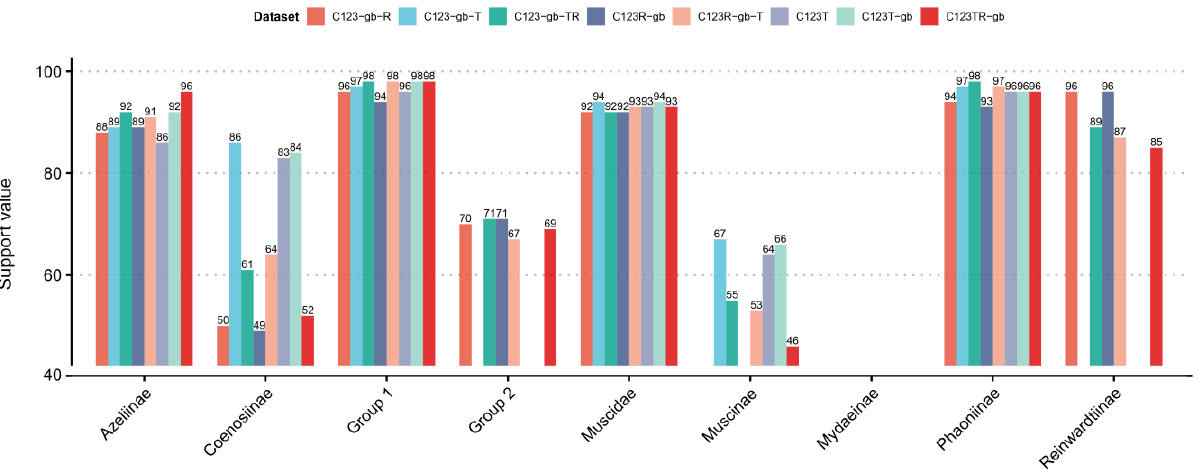
Figure 2. The support values of major nodes among various datasets. These nodes with same support value among datasets were hidden. The node names in x-axis were same as Figure 1. “C123”: all three loci of protein-coding gene; “T”: tRNA gene; “R”: rRNA gene. The loci followed with a “-gb” mark in the dataset name were trimmed by gblocks .